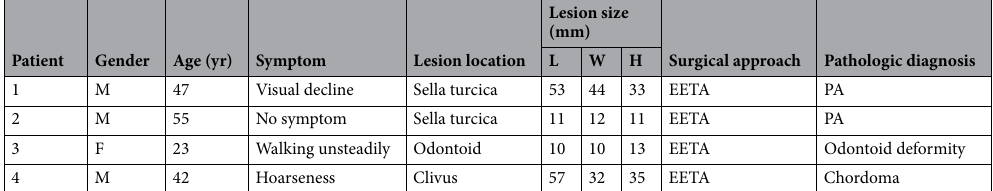
Table 3. Data of patients who received resection of intracranial skull base lesions with the assistance of 3D printing technique. M male, F female, yr year, L length, W width, H height, EETA endoscopic endonasal transsphenoidal approach, PA pituitary